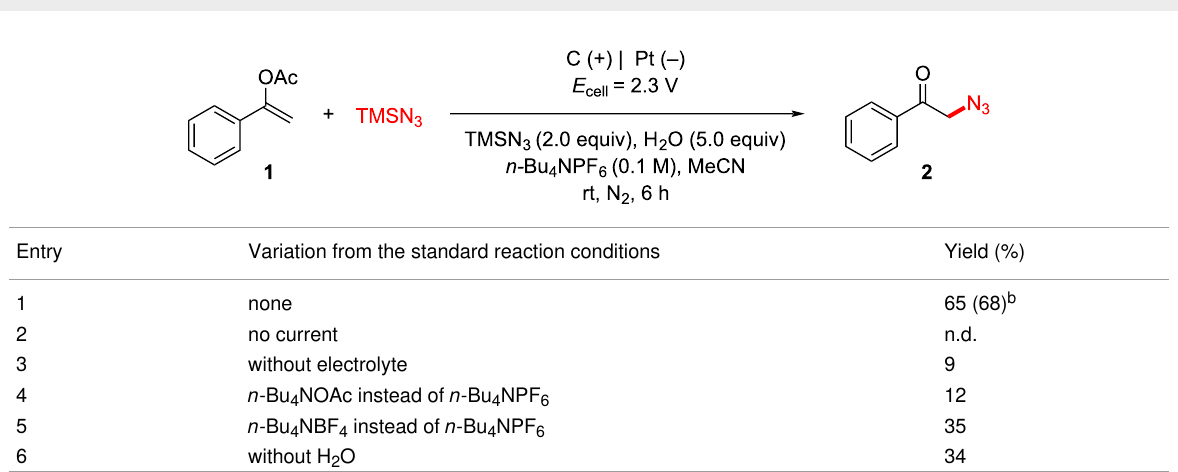
Entry Variation from the standard reaction